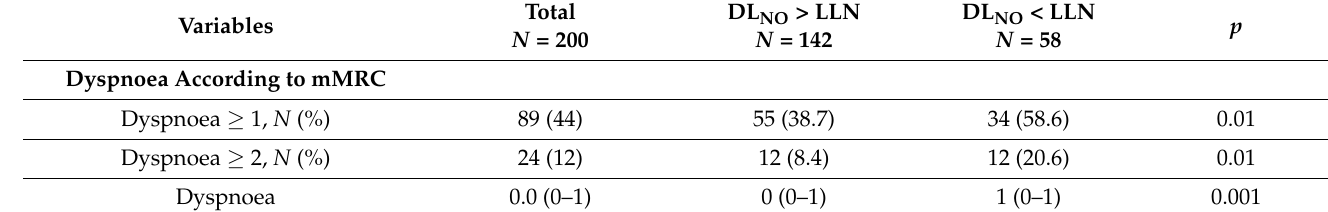
Table 4. Degree of dyspnoea, health status, capacity for physical exertion, analytical determinations, and radiological resolution at 12 weeks, according to whether DL NO < LLN or